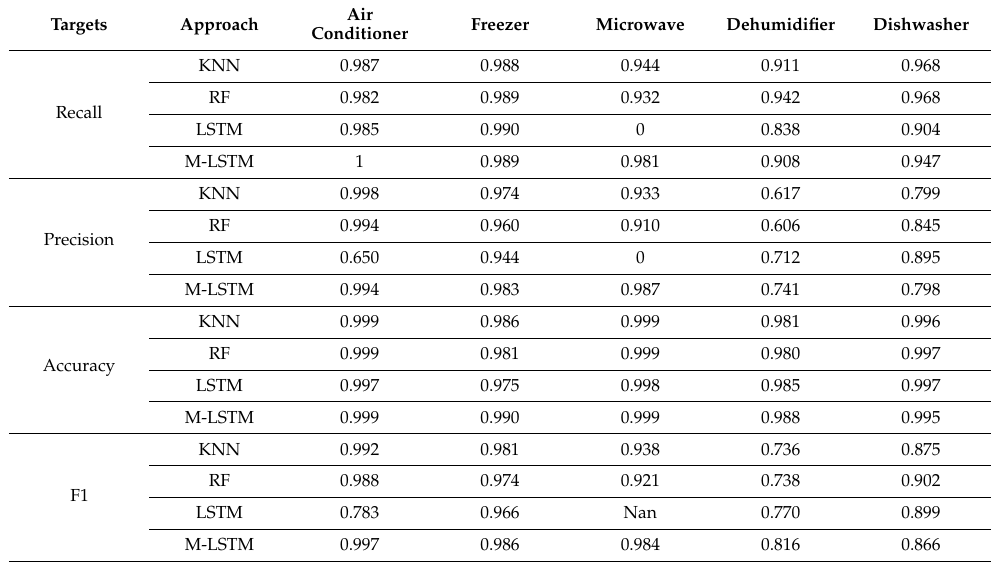
Table 4. Comparison of UK-DALE No. 5 home load operating state indicators.